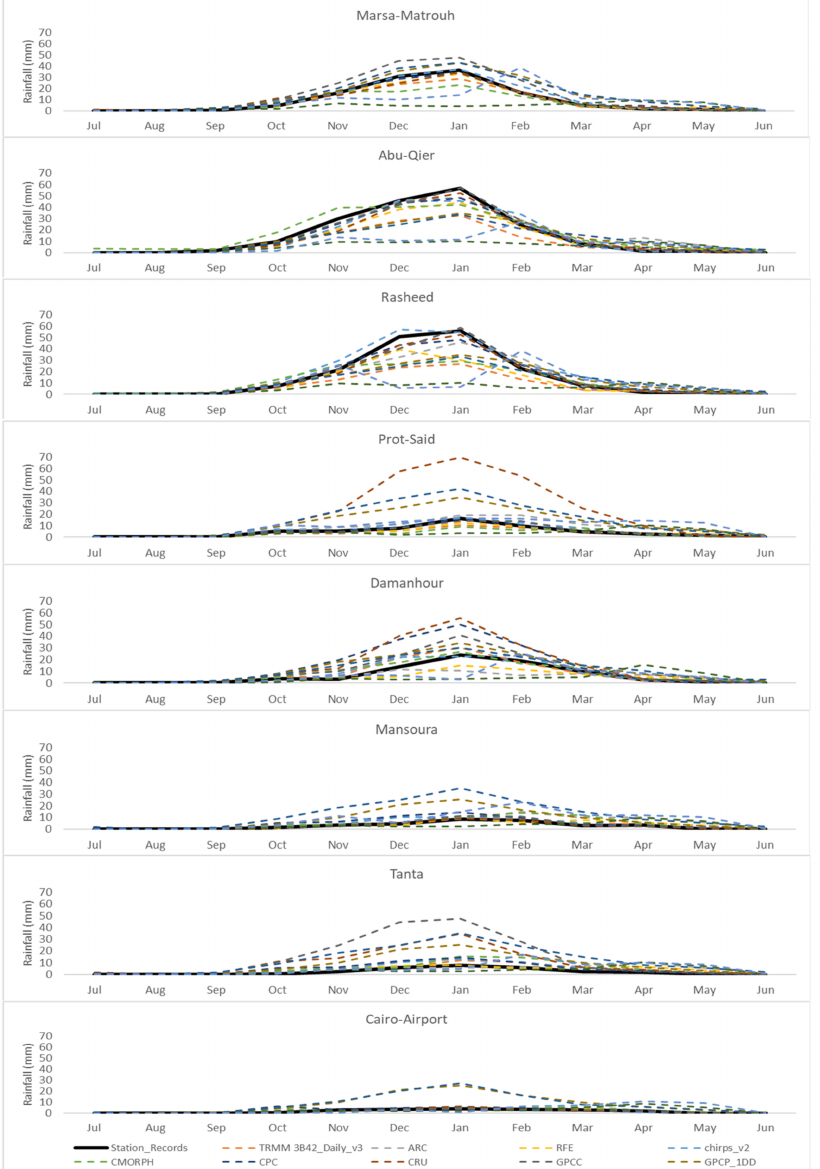
Figure 4. Annual cycle of mean monthly rainfall for tested